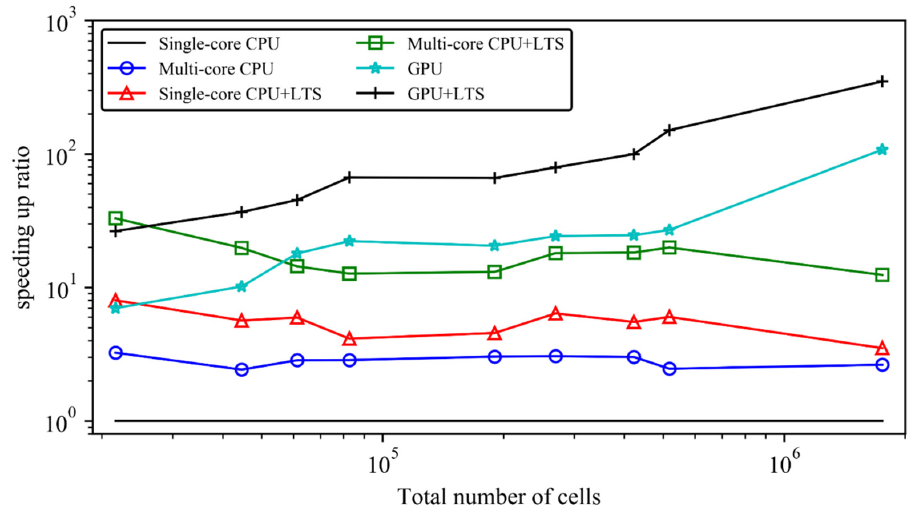
Figure 10. Speeding-up ratios of the six SWM versions for simulations of tidal flows, as compared to the single-core CPU version.